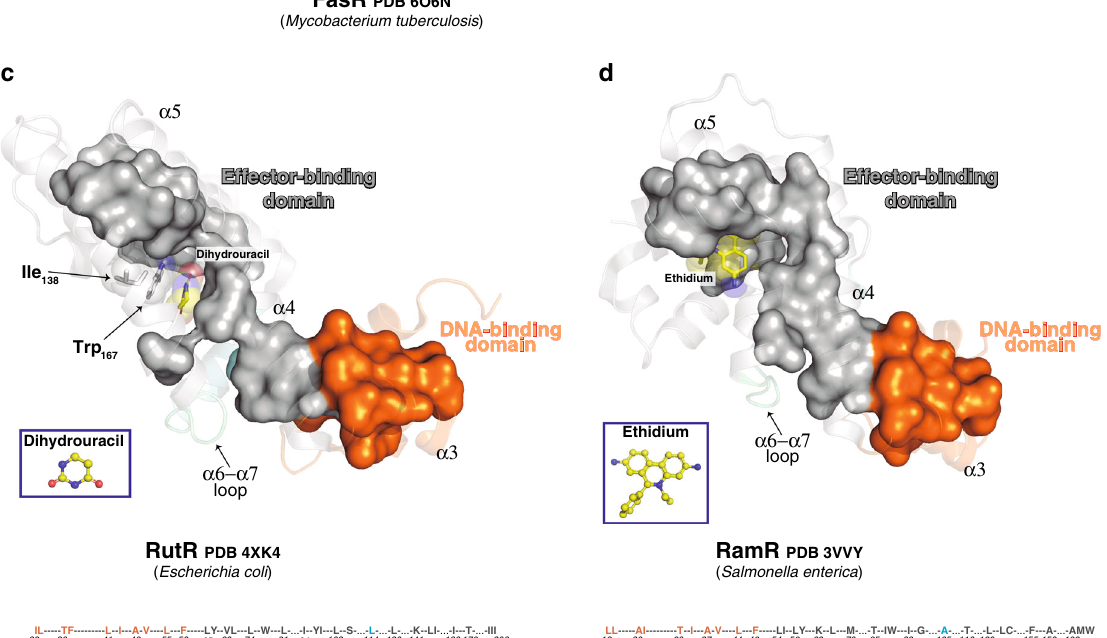
Fig. 6 A hydrophobic spine connects input effector-sensing to output DNA-binding. a Hydrophobic-spine amino acids in FasR. The colour code depicts residues of the DNA-binding domain in orange, the effector-binding domain in grey and the α 6 – α 7 loop in cyan. b – d distinct TFRs (FasR, RutR, RamR) illustrate the conservation of the hydrophobic spine (residues shown as molecular surface), connecting effector- to DNA-binding domains. The colour code is identical to panel a . The effector molecules in atom-coloured sticks are labelled, with transparent spheres overlaid (insets show their markedly disparate structures). See Supplementary Fig. 13 for additional